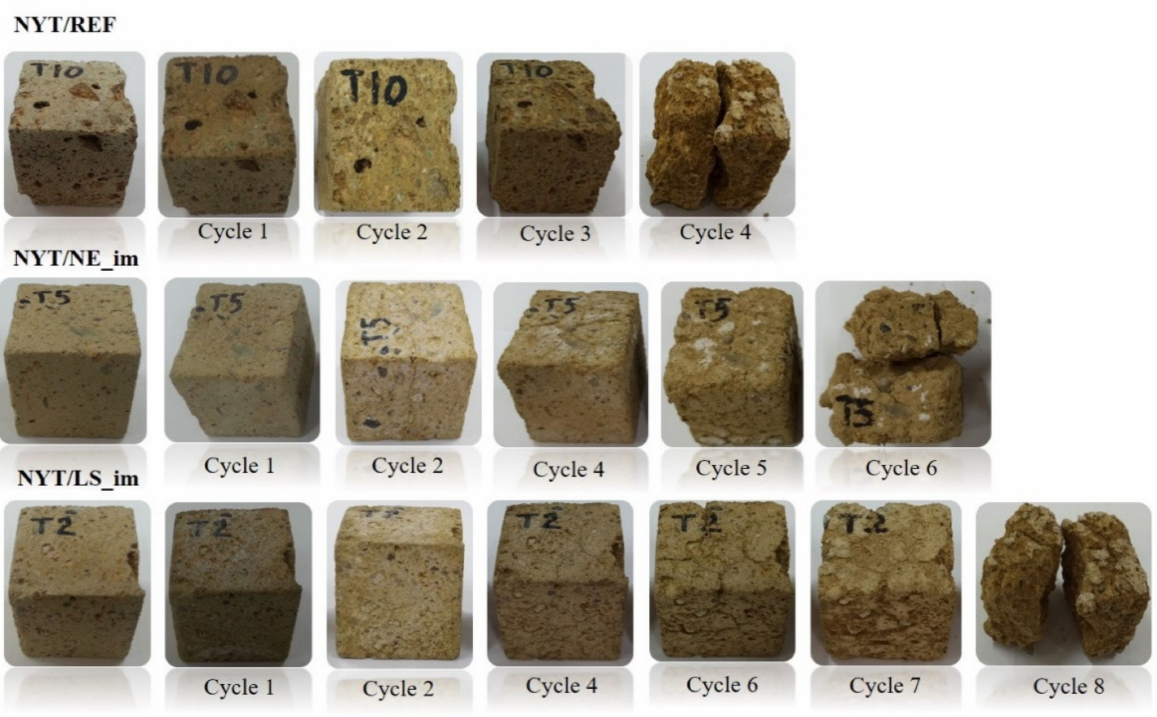
Figure 12. NYT samples during salt crystallization